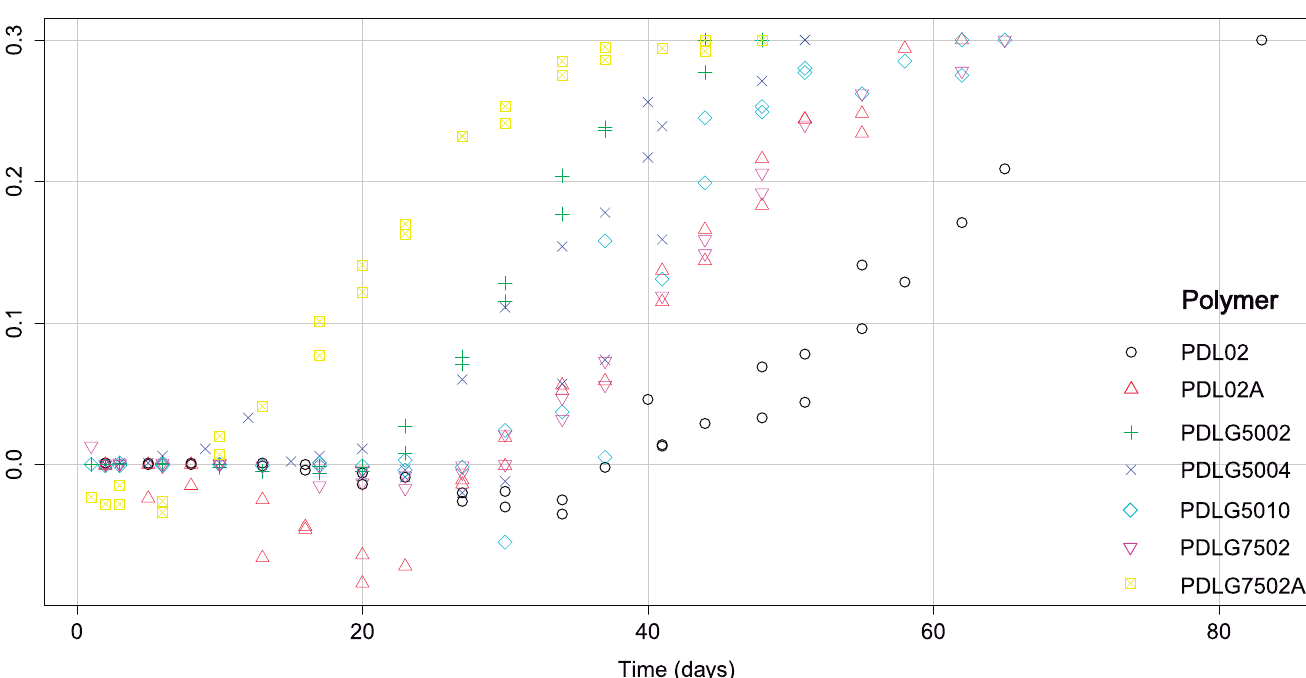
Fig 3. Experimental data of mass loss vs time corresponding to the 7 different polymers. Note that the two degradation trajectories corresponding to each polymer are shown in the same colour.